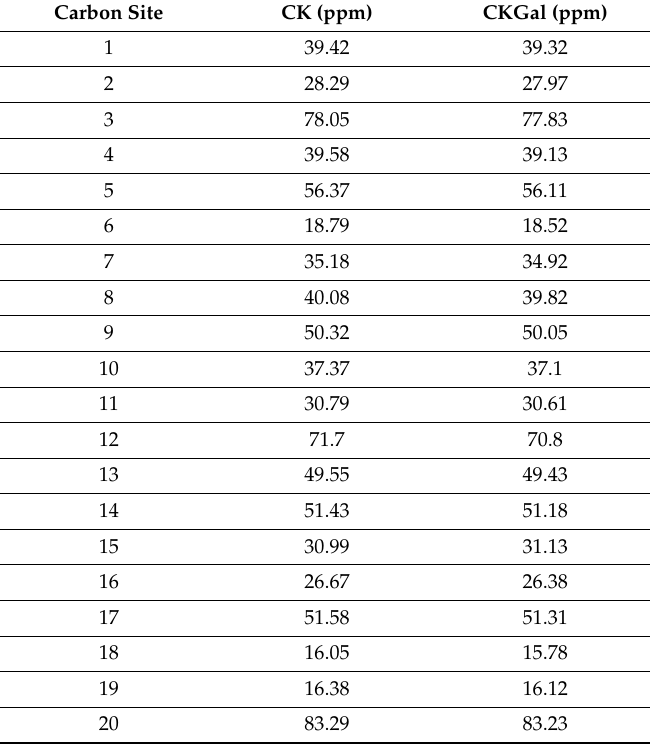
Table 1. 13 C-NMR of ginsenosides, 20- O -[ β -D-glucopyranosyl]-20( S )-protopanaxadiol (CK),